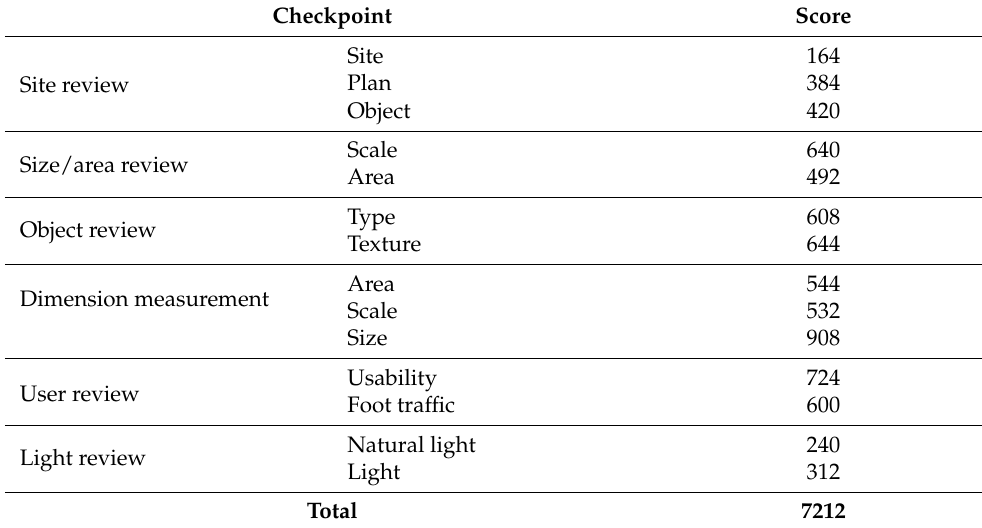
Table 4. Survey results for function development of visualization review